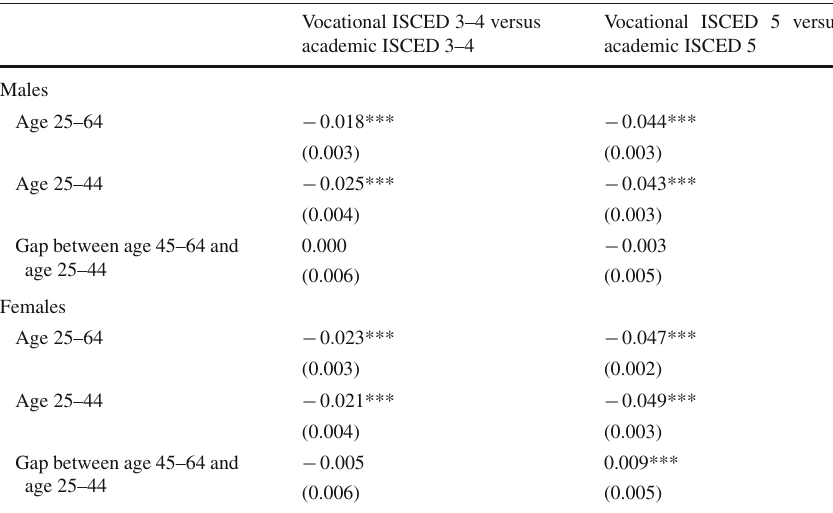
Table 4 Aggregated average treatment effects. Dependent variable: log problem solving score. Source : Calculations based on PIAAC data Vocational ISCED 3–4 versus academic ISCED